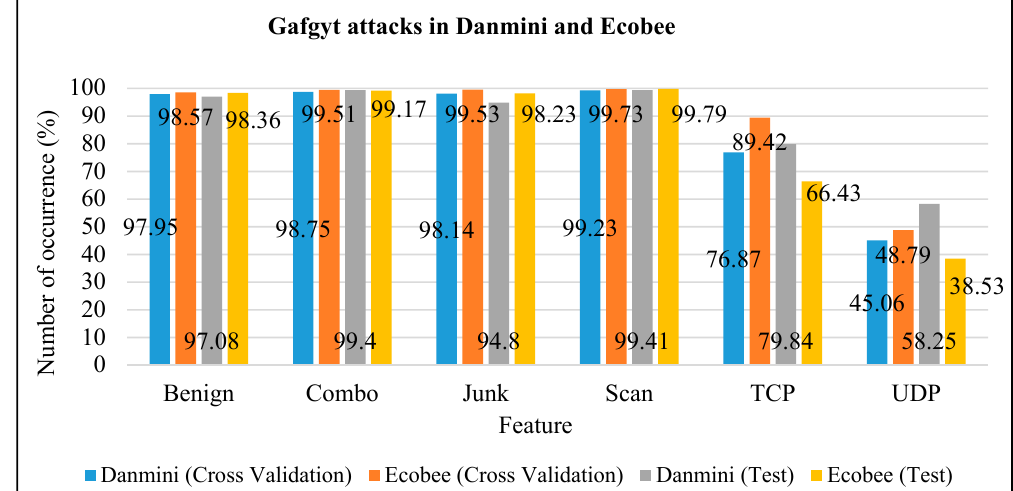
Figure 7. Number of occurrences in Danmini and Ecobee for cross validation and test analysis in different features.